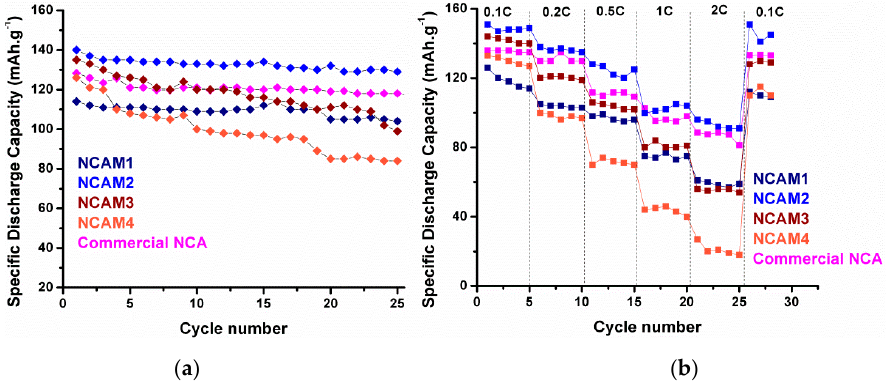
Figure 15. ( a ) Cycle performance and ( b ) rate-ability of as-prepared NCA at various precursor solute ion concentrations.